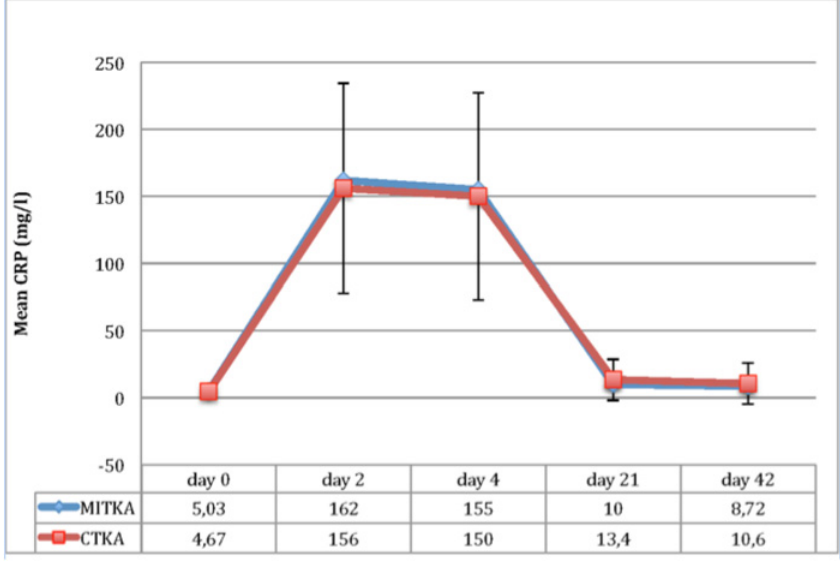
Fig 1. Evolution of CRP in the two TKA groups during six weeks(Values for the MITKA group compared to the CTKA group were not significantly different at any time